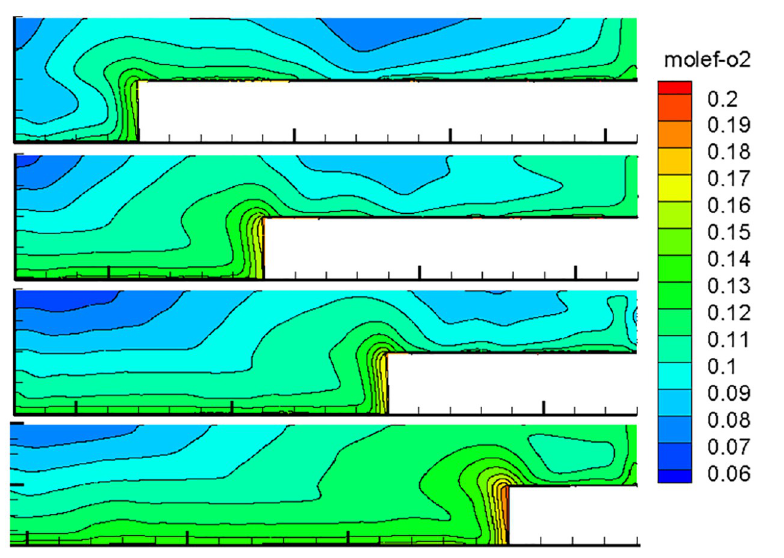
Fig 8. Flow field distribution of the oxygen volume fraction in the goaf at 1% air leakage.